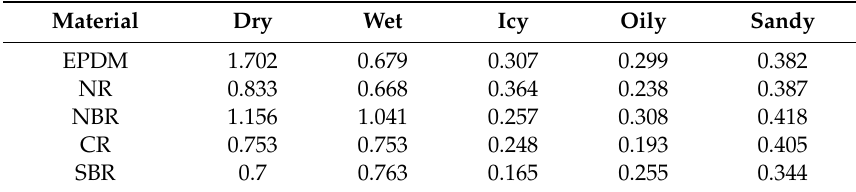
Table 2. The friction coefficients (µ min ) test results.